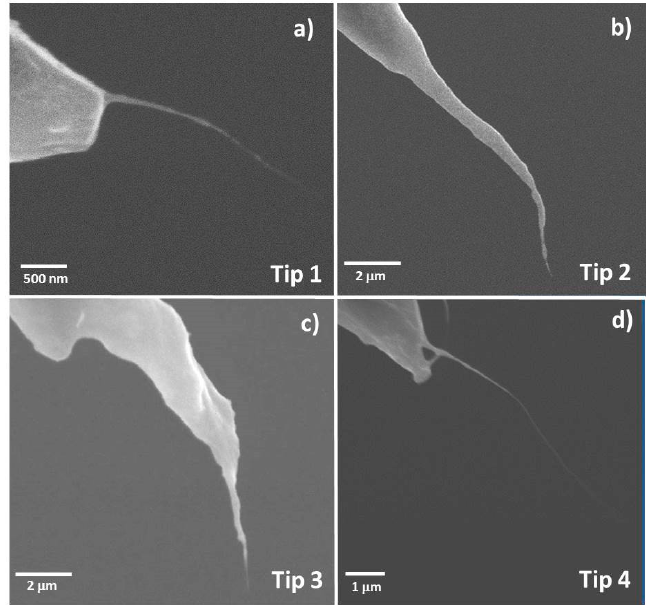
Figure 1. ( a – d ) 4 unique CNT tips fabricated by the DEP technique with 2.5 V potential, 1 MHz modulation and 20 s deposition.